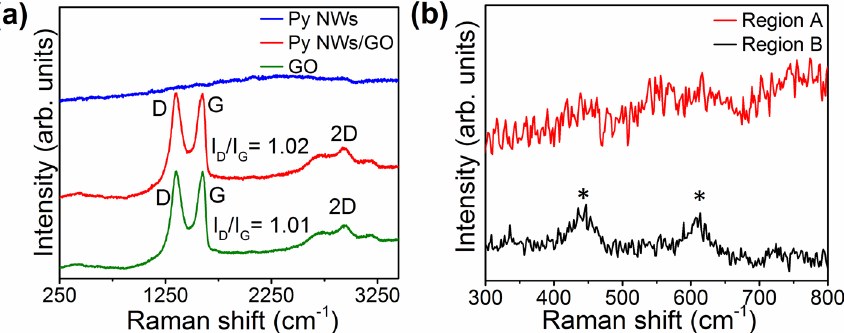
Figure 5. ( a ) Raman spectra of GO (green), Py NWs/GO composite (red), and Py NWs (blue). ( b ) Raman spectra of two different regions (A: red, B: black) in the decoupled Py NWs